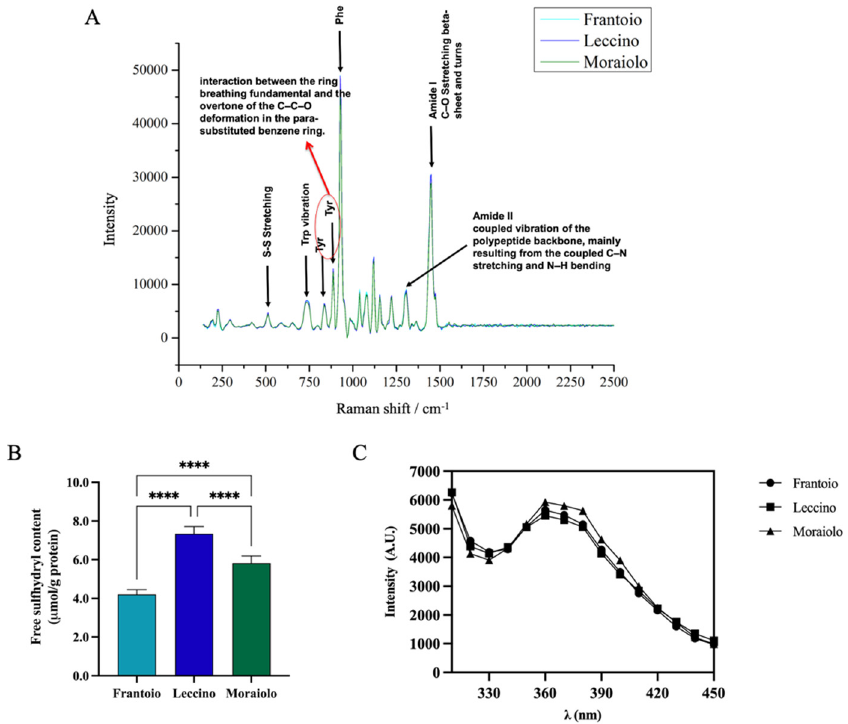
Figure 2. ( A ) Secondary structure analysis by Raman spectroscopy (125–2500 cm − 1 region).